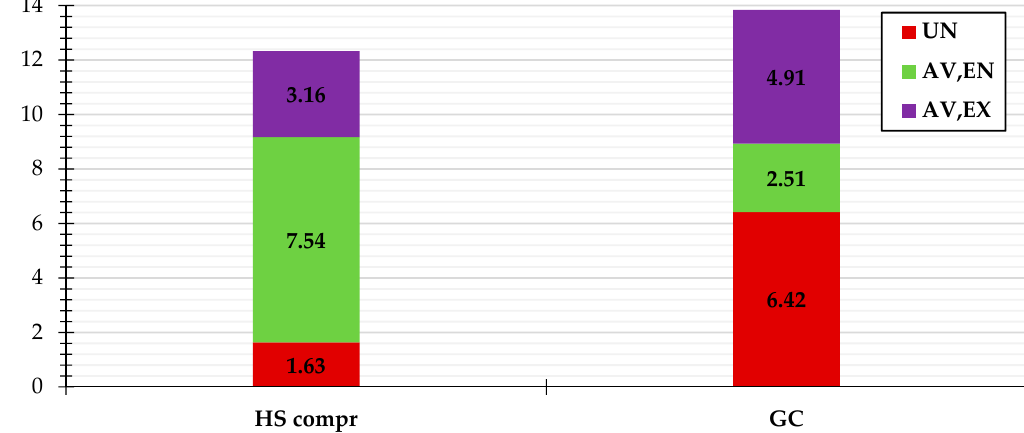
Figure 7. Exergy destruction rates associated with some selected components belonging to the improved system (“Improved” DMS) at the outdoor temperature of 40 °C.